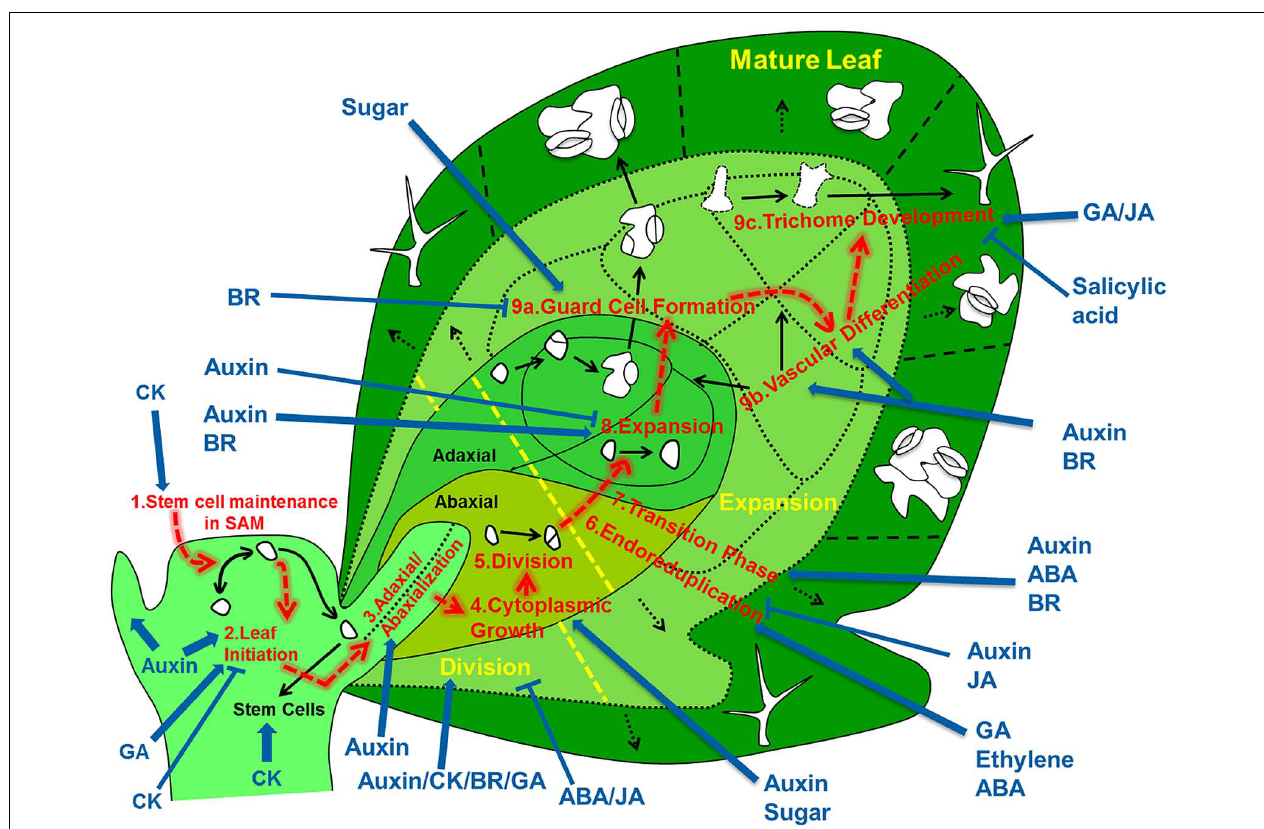
FIGURE 1 | Overview of the regulatory processes that determine the development of a leaf. The cells that form the leaf originate from the stem cell niche at the shoot apical meristem. As a first step in their development, cells need to loose stem cell identity (1). A leaf primordium is initiated in groups of cells that migrate into the lateral regions of the SAM (2), which further acquires upper (adaxial) and lower (abaxial) sides through leaf-polarity control (3). Afterward, the transformation of the small leaf primordium to a mature leaf is controlled by at least six distinct processes: cytoplasmic